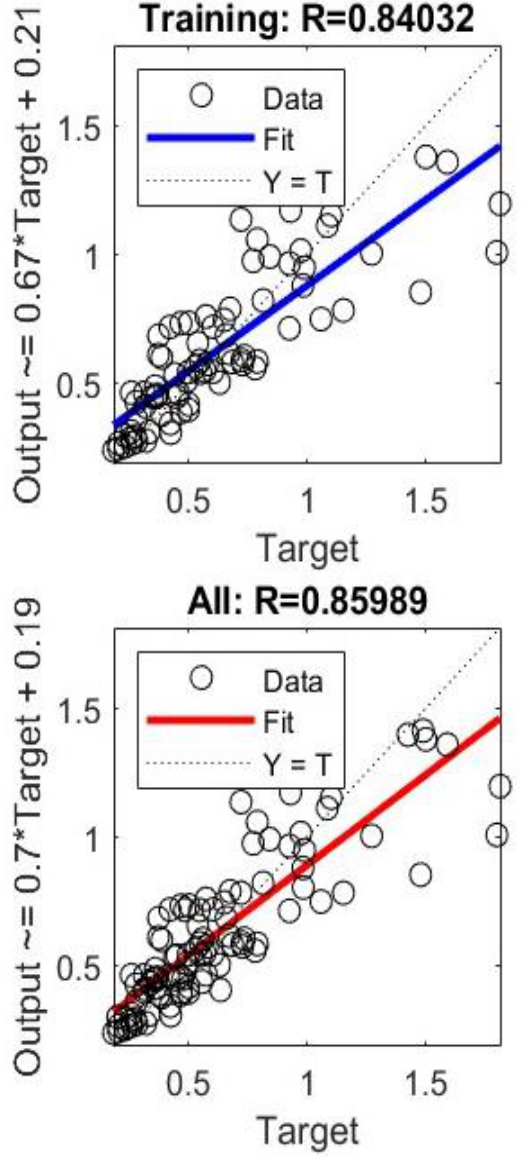
Figure 10. Actual and predicted data distribution with the fit line: the white circles are data points, and blue, green, and red lines are the best-fit lines.